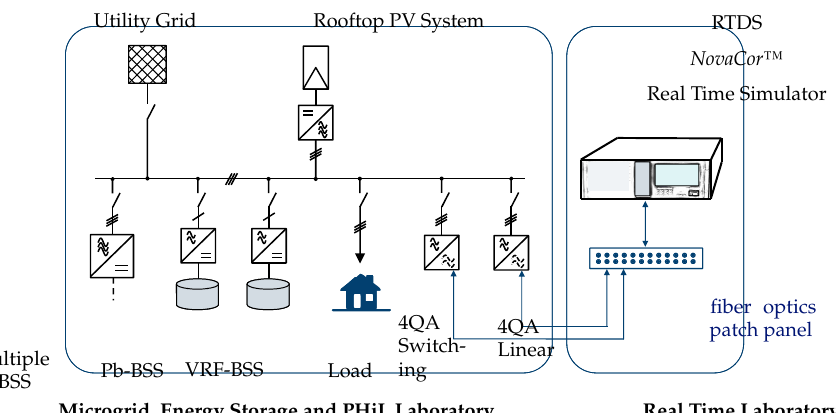
Figure 1. Setup of the Microgrid, Energy Storage and Power Hardware-in-the-Loop Laboratory in collabo- ration with the Real Time Laboratory of the LEES.